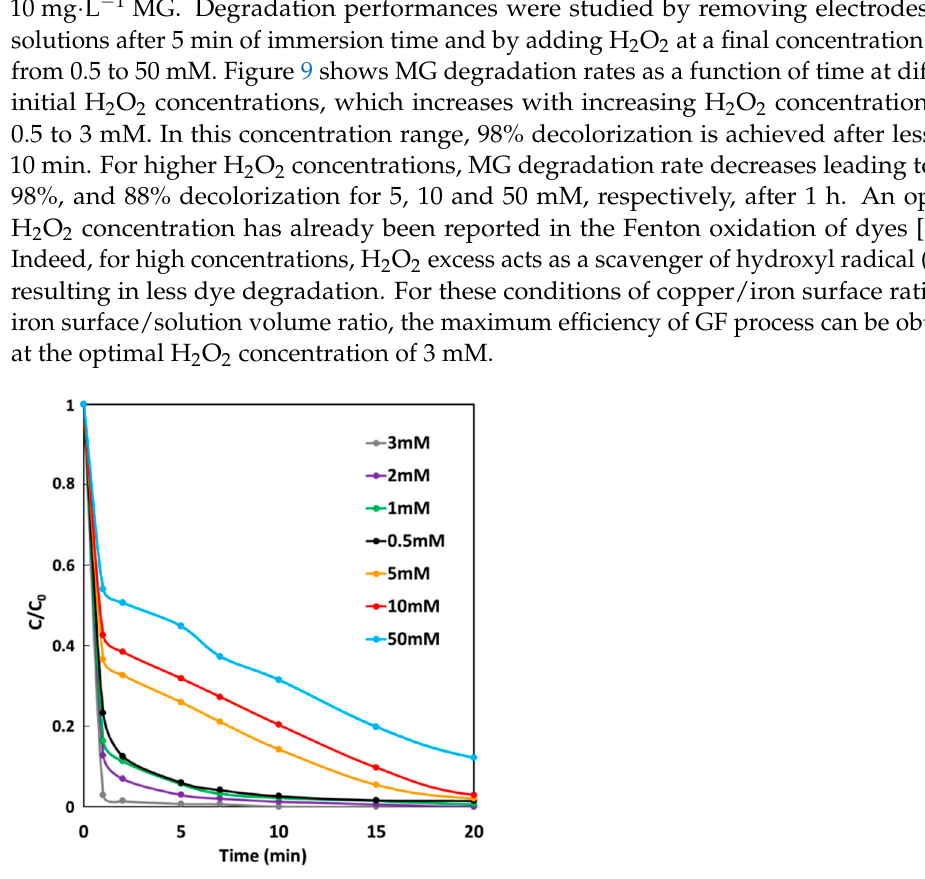
Figure 10. Effect of MG concentration on the degradation rate during the GF process. 3. Materials and Methods 3.1. Materials